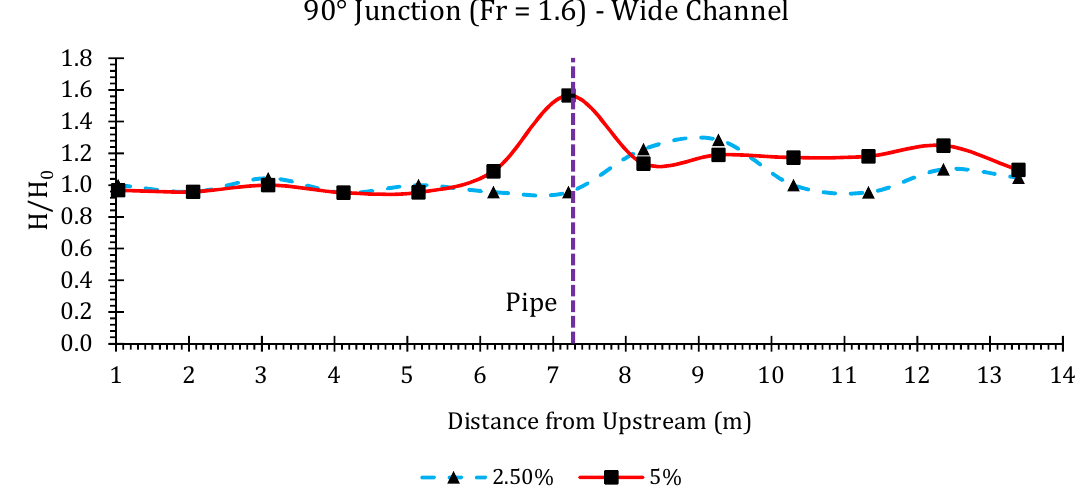
Figure A12. Water height ratios in a 90° junction for Fr = 1.6 in the wide channel.